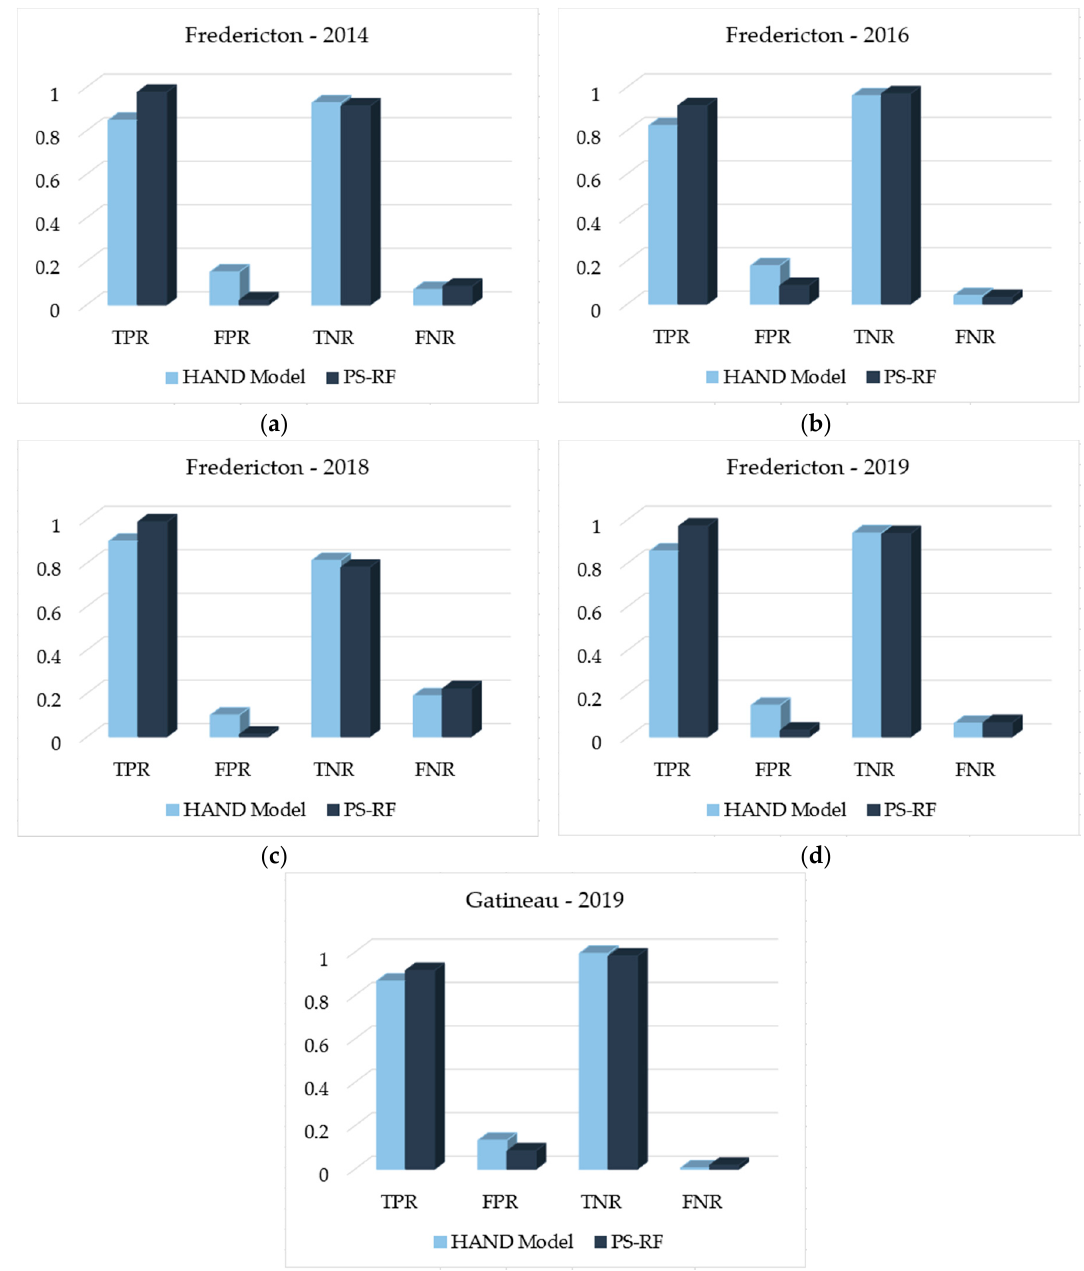
Figure 10. True positive rate (TPR), true negative rate (TNR), false positive rate (FPR) and false negative rate (FNR) for the five flood events ( a ) Fredericton 2014, ( b ) Fredericton 2016, ( c ) Fredericton 2018, ( d ) Fredericton 2019 and ( e ) Gatineau 2019.